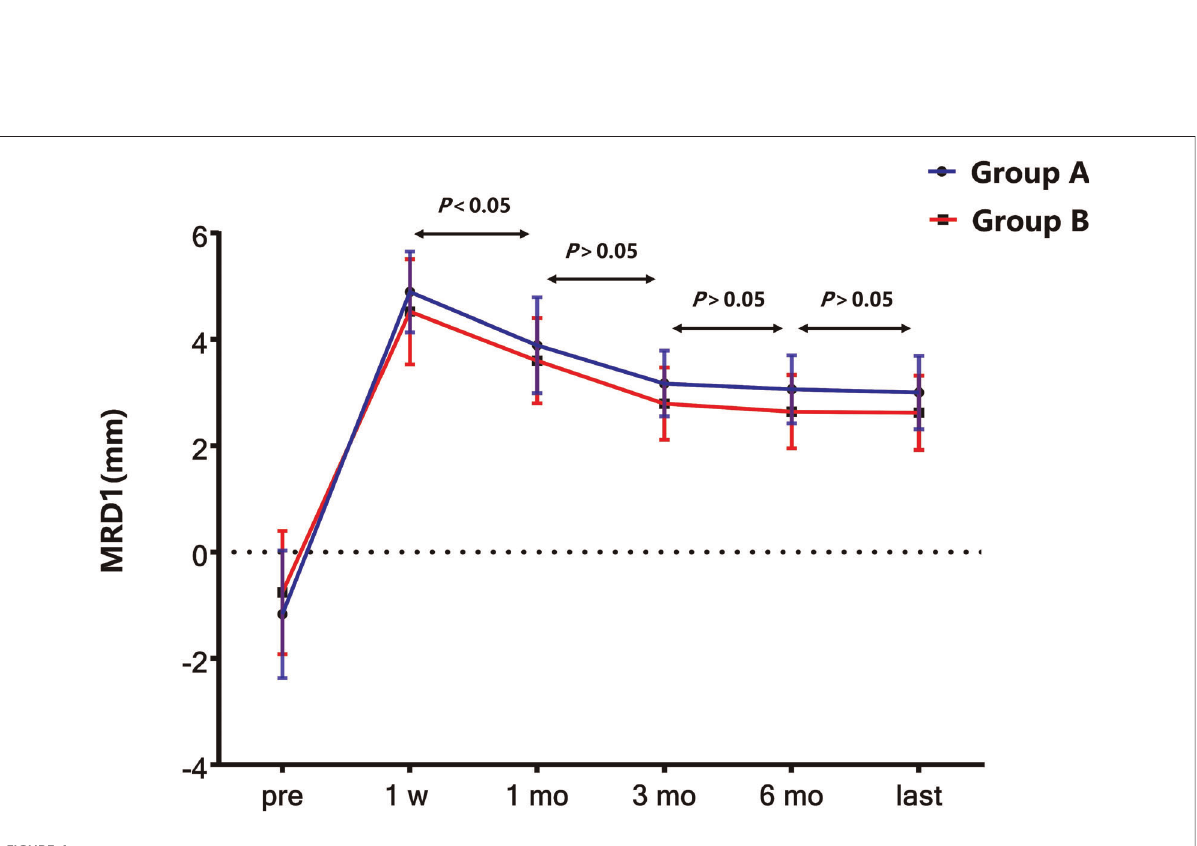
FIGURE 4 MRD1 regression in two groups at different follow-up